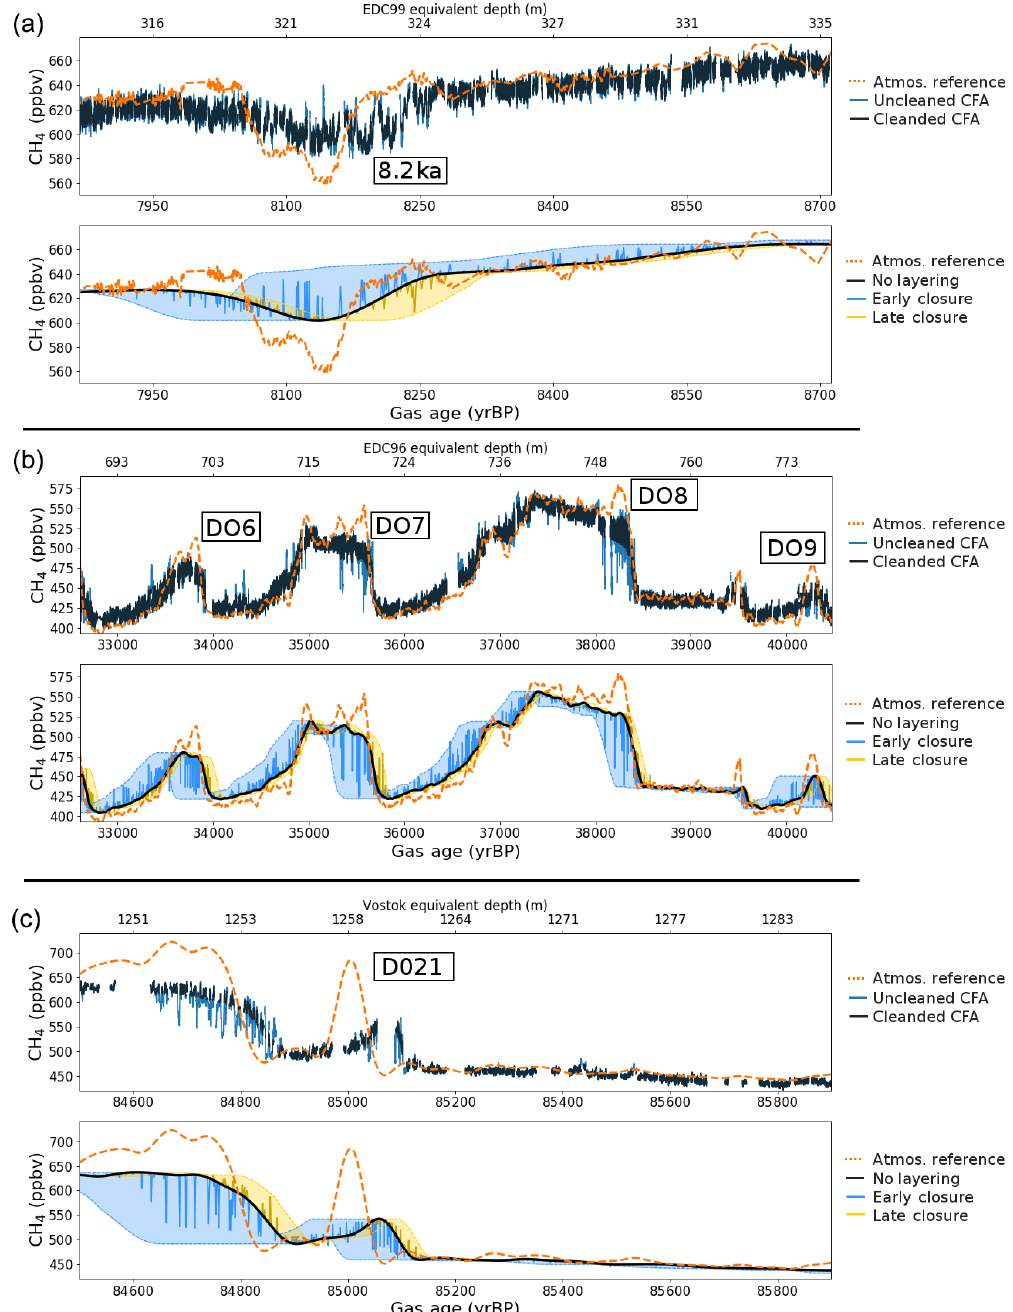
Figure 4. Same as Fig. 3 for the (a) Holocene Dome C, (b) DO6-9 Dome C, and (c) DO21 Vostok sections. In addition the superimposed black signals in the upper panels show the data cleaned of layering